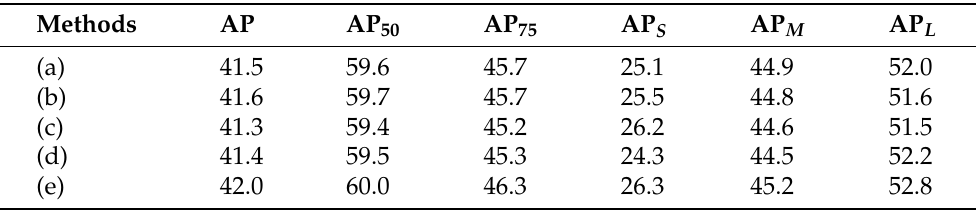
Figure 4. The ( a – e ) are diagrams of alternative architectures of DsFE module. The ‘reg subnet’, ‘cls subnet’ and ‘obj subnet’ mean the four convolutional layers on top of FPN feature maps in regression, classification and objectiveness branches, respectively. Table 6. Results of DsFE module with different architectures on COCO val2017 set. The (a)–(e) indexes in the first column denote corresponding architectures that are presented in Figure 4.